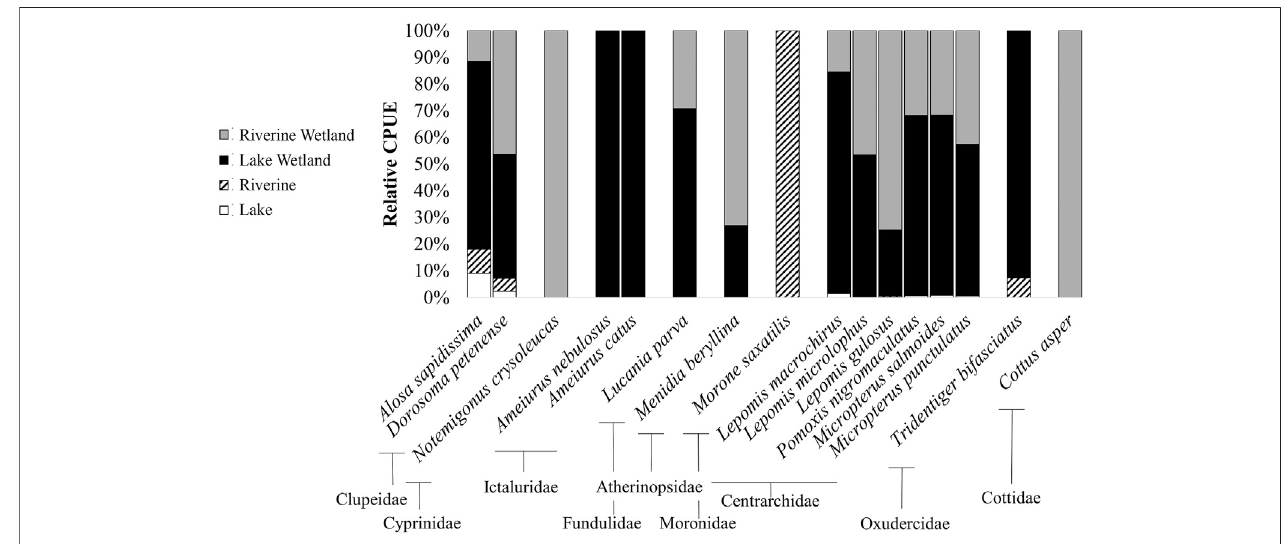
FIGURE 4 | Relative Catch Per Unit Effort (CPUE) for 16 fi sh species, depicting overall habitat use patterns in Mildred Island within the Sacramento-San Joaquin Delta, California, 26 July to 31 August 2018.